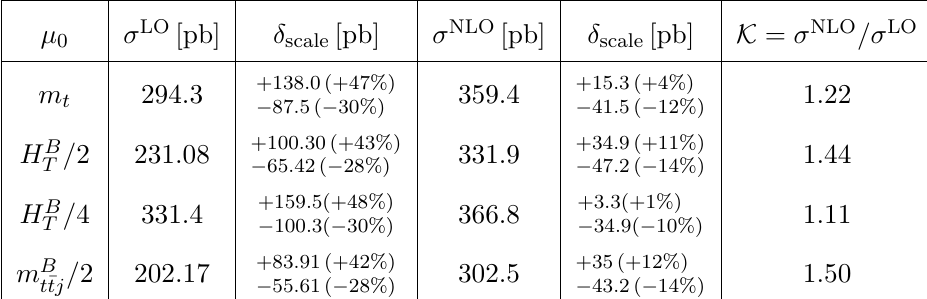
Table 1 . Integrated cross section at LO and NLO of the process pp → t ¯ tj + X with the analysis cuts N j ≥ 1 , p j > 30 GeV and | η j | < 2 . 4 , where the anti- k T jet clustering algorithm with R = 0 . 4 T and the CT18 NLO PDF set were used. The scale variation uncertainty δ scale is obtained according to the seven-point scale variation procedure described in section 2. In each δ scale column, the first number refers to the absolute uncertainty due to scale variation, whereas the second number, indicated in parentheses, gives the same uncertainty in a percentage